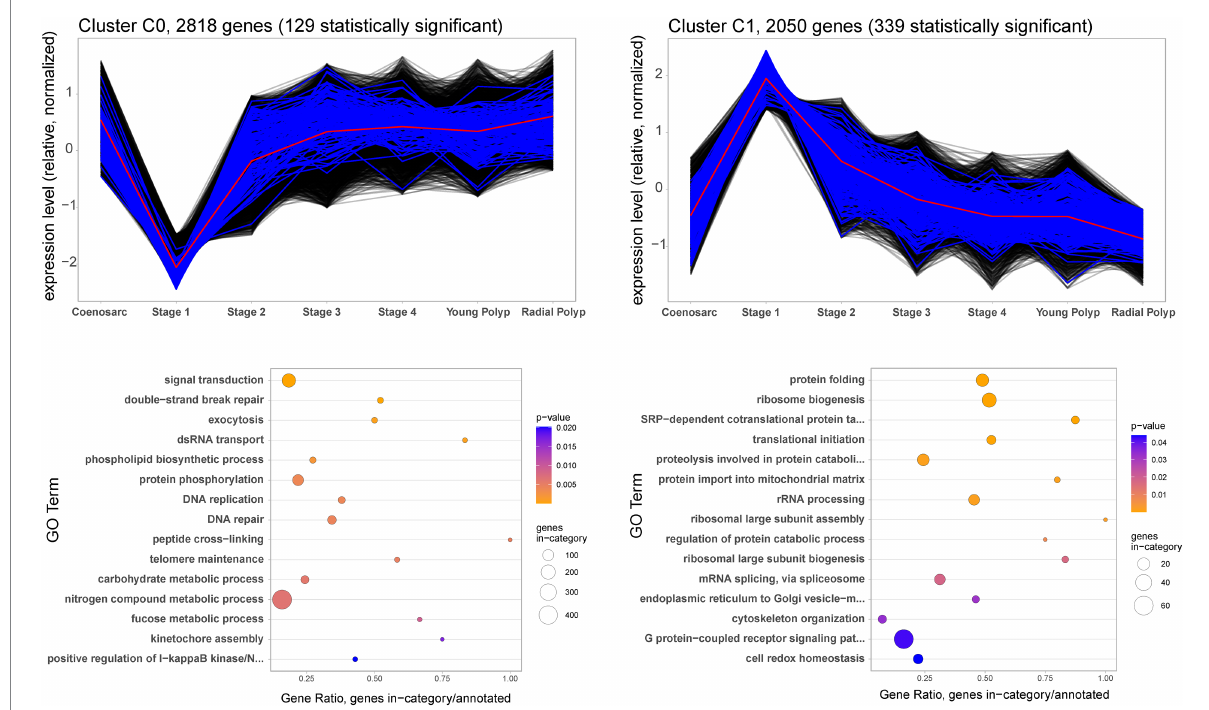
FIGURE 4 Gene expression clusters (top) and Biological Processes identified as Gene Ontology terms associated with them (bottom) during A. millepora wound healing and polyp regeneration. The black and blue lines show expression profiles of individual genes included in the cluster. The genes with expression statistically significantly different in Stage 1 (adj. value of p ≤ 0.05) – lower for C0 and higher for C1 – are shown in blue, and those with not-significantly different expression in black. The red lines represent mean expression profile calculated from all the genes included in the